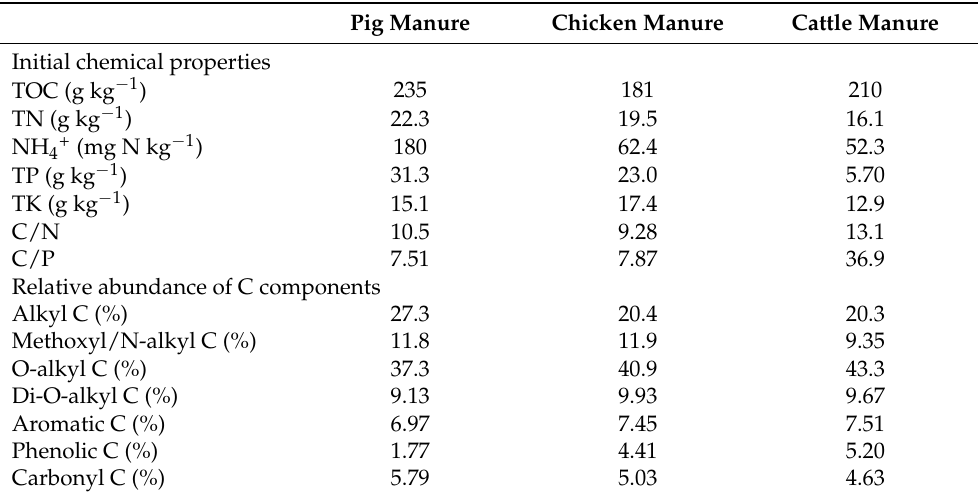
Table 1. Initial chemical properties (expressed on an oven-dried basis) and relative abundance of C components detected using 13 C CPMAS NMR in pig, chicken, and cattle manures. Pig Manure Chicken Manure Cattle